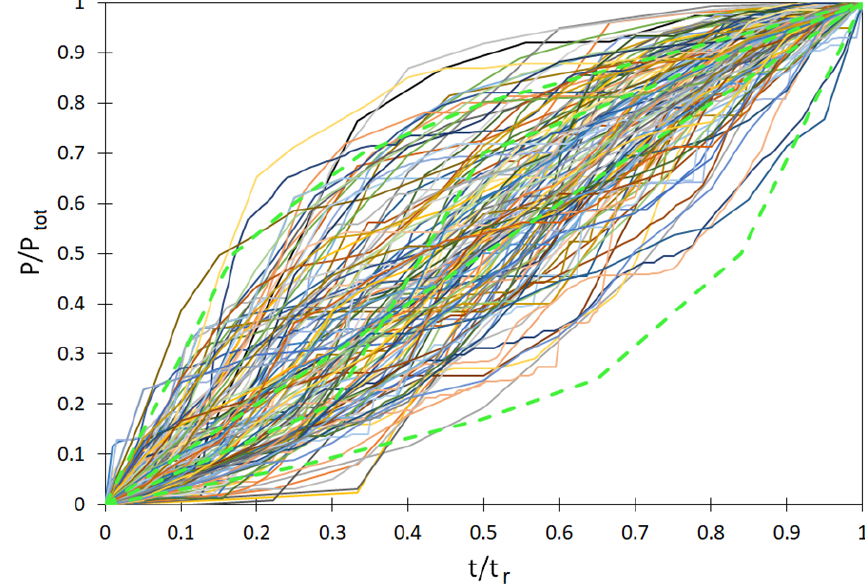
Figure B2. Comparison of measurement results of hydrographs of outflow from the catchment area with GLUE calculations.